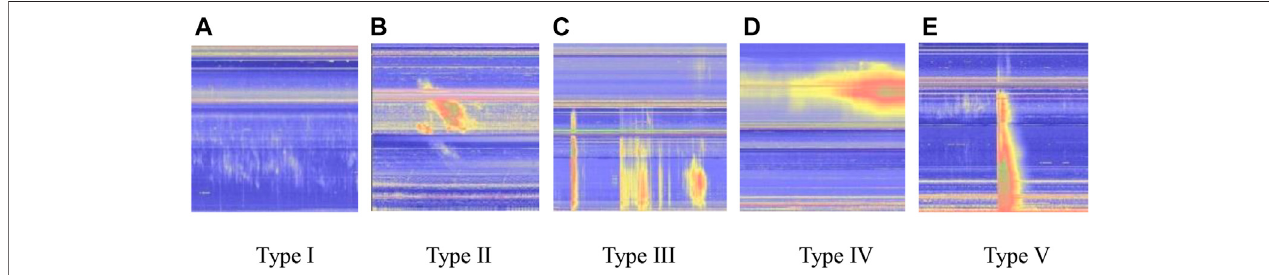
FIGURE1| ExamplesoftypeI – typeVsolarradioburstsobservedinthemetricdecametricwavelengths (A – E) .Thespectrausedinthisstudyareobtainedfromthe Australian Bureau of Meteorology ’ s Culgoora Observatory and Learmonth Observatory (http://www.sws.bom.gov.au/World_Data_Centre/1/9). The Culgoora Observatorymonitorssolarradioburstsinthefrequencyrange18 – 1800 MHz,andtheLearmonthObservatoryradioobservatorymonitorssolarradioburstsintherange 25 – 180